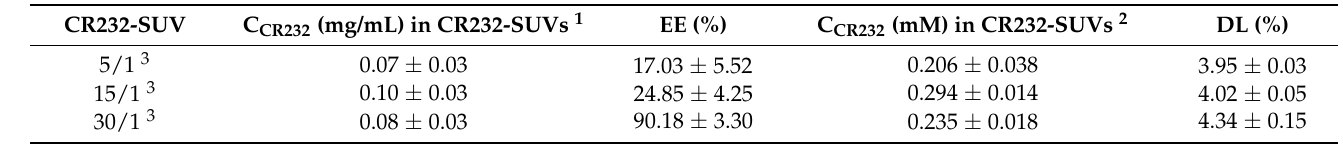
Table 5. Values of the concentrations of CR232 in CR232-SUVs 5/1, 15/1, and 30/1, as well as EE%, and